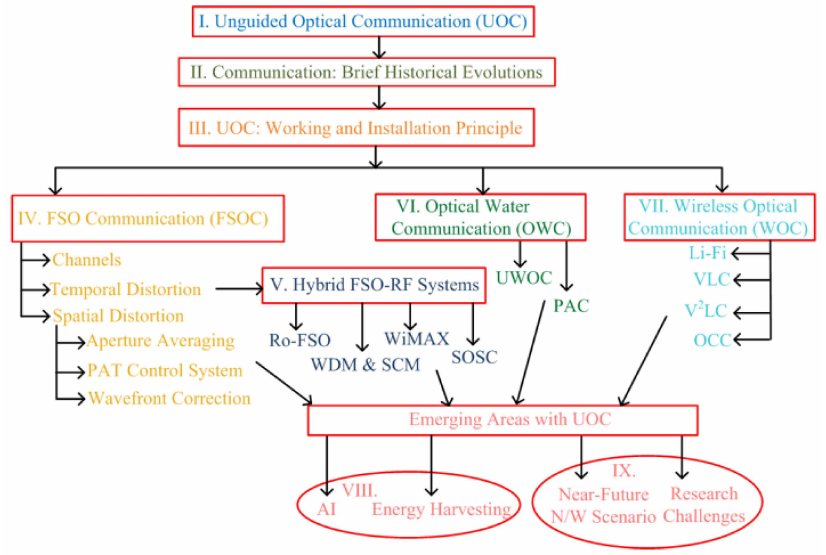
Figure 1. Categorical revolution roadmap of UOC up to today’s